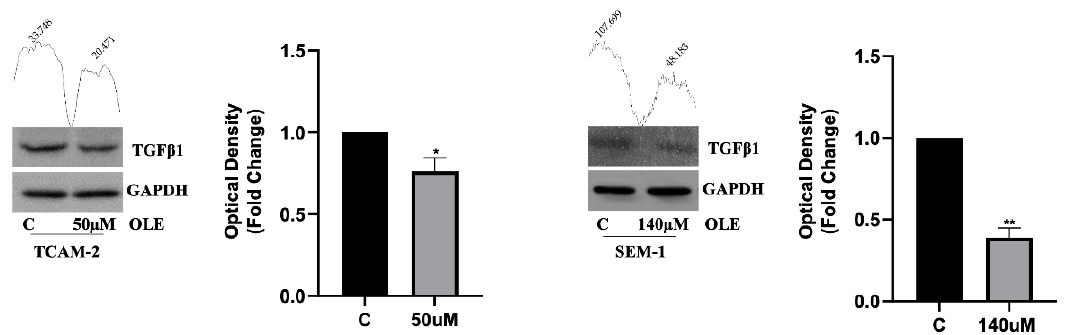
Figure 5. Western blot analysis shows a down-regulation in both TCAM-2 and SEM-1 cells after OLE treatment (50 µM for TCAM-2; 140 µM for SEM-1) for 48 h. GAPDH was used as loading control. The histograms represent the mean ± SD of three separate experiments (each performed in triplicate) in which bands intensities were evaluated as optical density and represented as fold change for treated vs. untreated cells normalized for the loading control. The numbers on the peaks reported on the top of each blot represent the size of the corresponding slot as a percentage of the total size of the two slots in each condition. * p < 0.05, ** p < 0.001 treated vs. untreated cells.